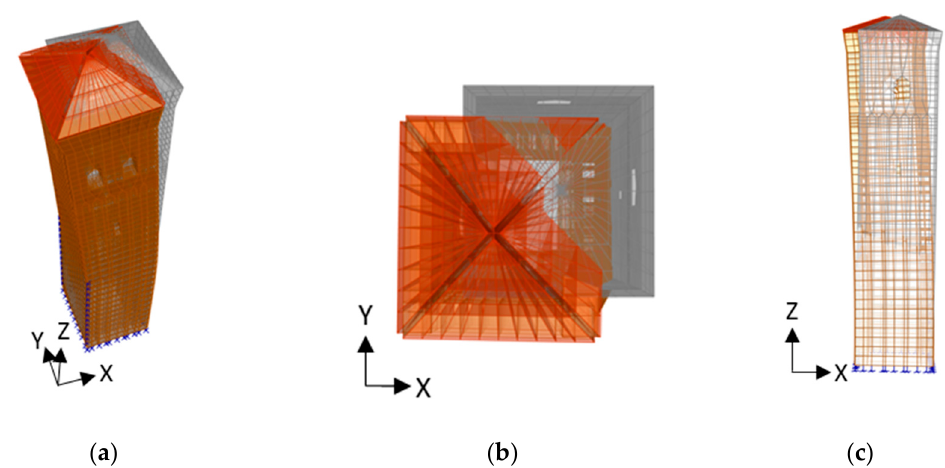
Buildings 2021 , 11 , x FOR PEER REVIEW